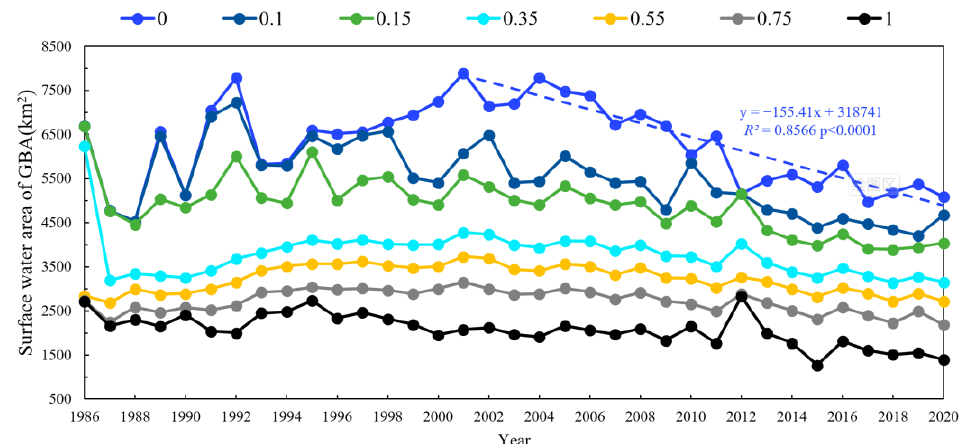
Figure 7. The temporal variation in the surface water area under different water inundation frequency thresholds in the GBA.